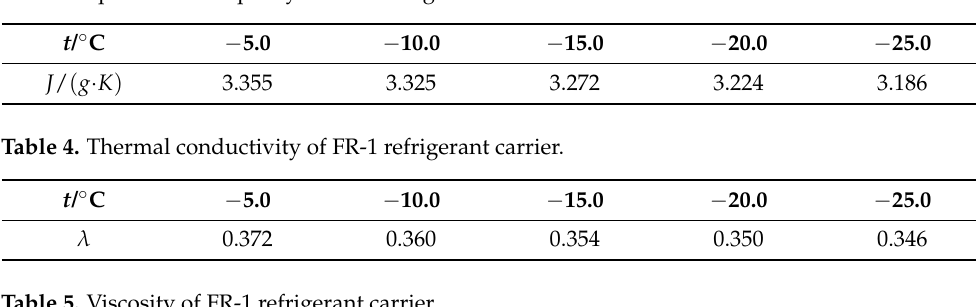
Table 3. Specific heat capacity of FR-1 refrigerant carrier.